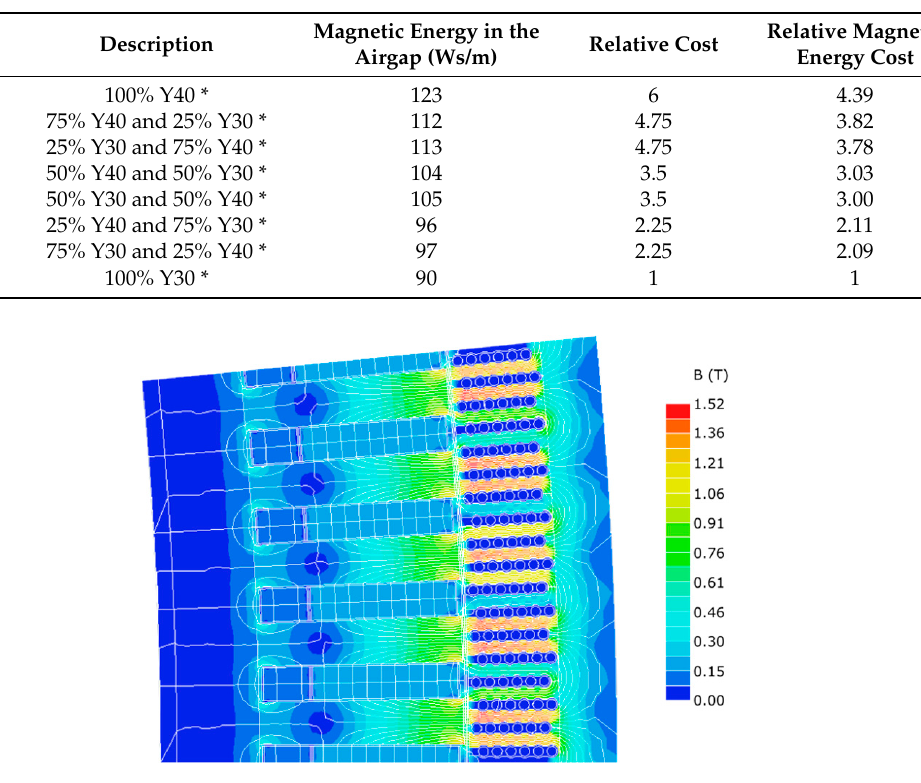
Figure 5. Magnetic field lines in the LG for Case 2b, where 75% of the PM is Y40 and 25% is Y30.